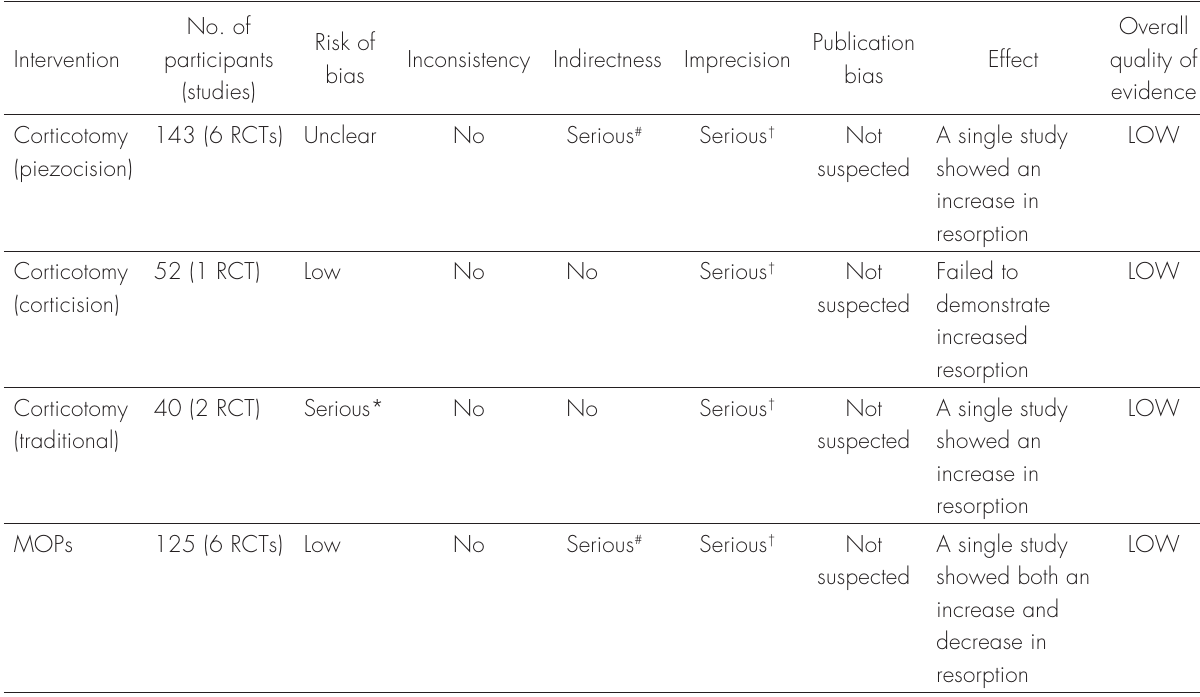
Table IV. GRADE Summary of Findings: Effect of Surgical Adjunctive Procedures Accelerating Tooth Movement on Root